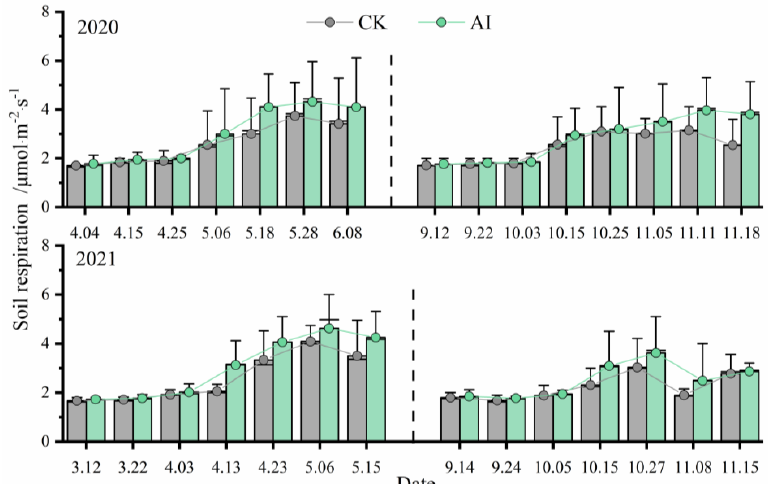
Figure 2. Dynamic change curve of soil respiration rate under different treatments (AI, aerated irrigation; CK, unaerated subsurface drip irrigation).